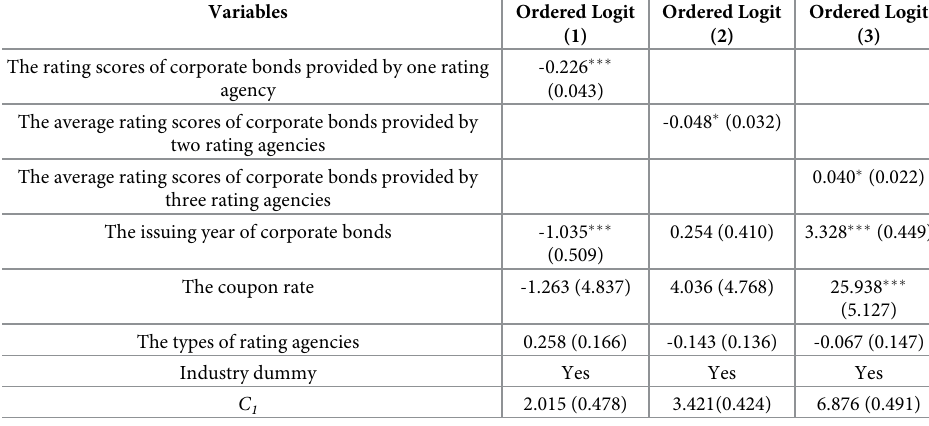
Table 5. Regression results of rating upgrades.